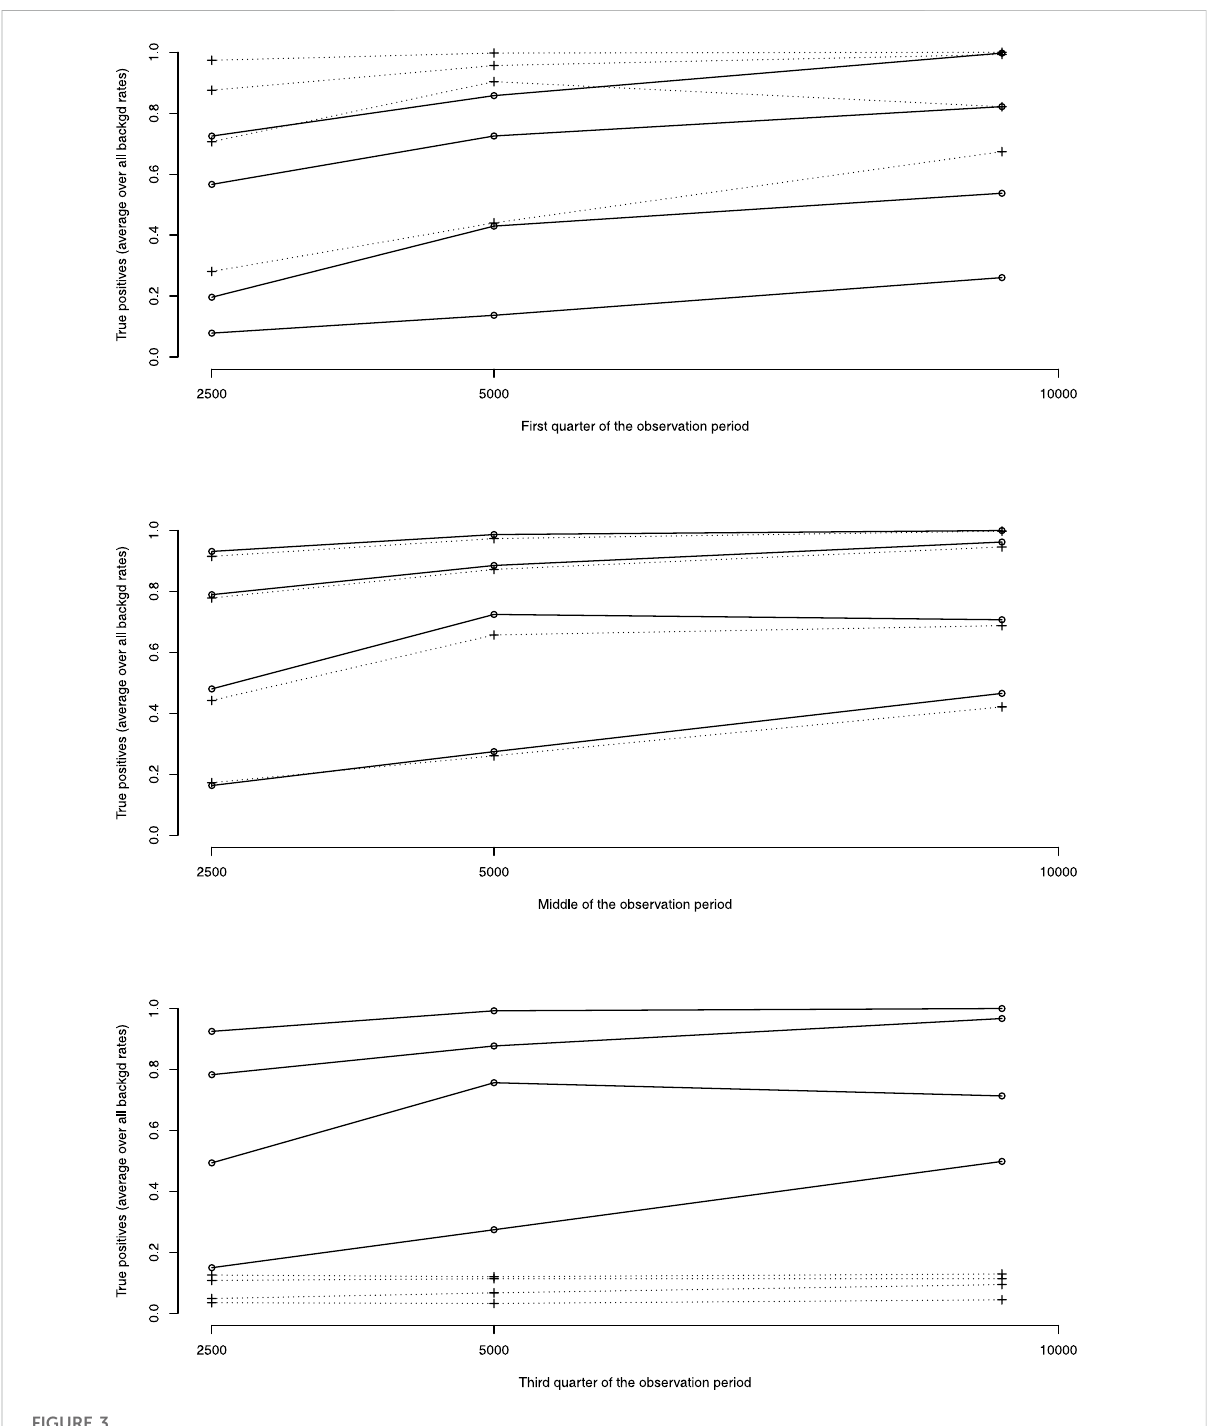
FIGURE 3 Average over all background rates of true positive rates by rates of ADRs as percentage of background rates (10, 20, 50 and 100%, rates increasing with ADRs rates). — dWSP ...